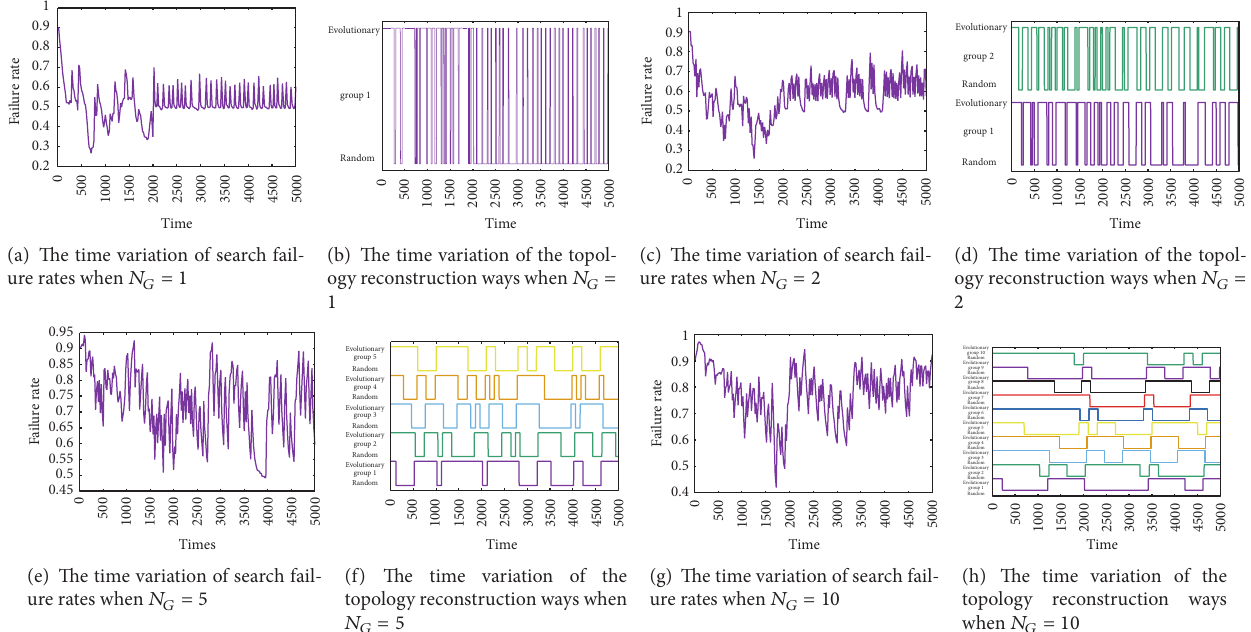
Figure 13: The result of one simulation run when using the simulation scenario that all nodes always stay in the network and the environment dynamically changes. The time variations of search failure rates are drawn in the subfigures (a), (c), (e), and (g) and the time variations of the topology reconstruction ways are drawn in the subfigures (b), (d), (f), and (h). The time variation of the topology reconstruction ways is represented by a sequential line graph, in which drawing a line on the upper side stands for the use of the evolutionary reconstruction strategy and drawing a line on the lower side stands for the use of the random topology